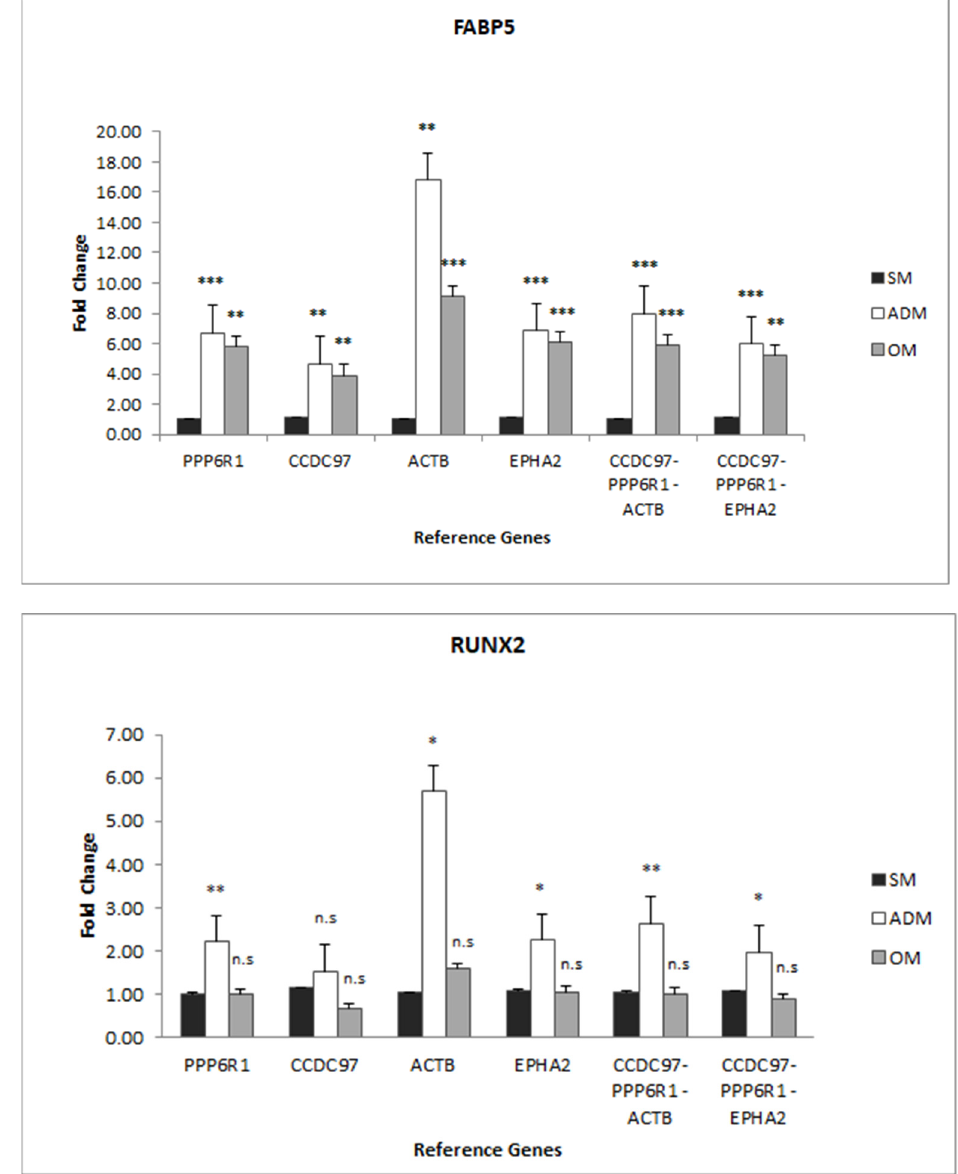
Figure 4. Relative expression of TGs, FABP5 , and RUNX2 in ADSC cells in response to SM, ADM, or OM conditions. The expression data were normalized using PPP6R1 , CCDC97 , ACTB , or EPHA2 RGs individually or the geometric mean of PPP6R1 + CCDC97 + ACTB or PPP6R1 + CCDC97 + EPHA2 . * p = 0.05, ** p = 0.01, *** p = 0.001.